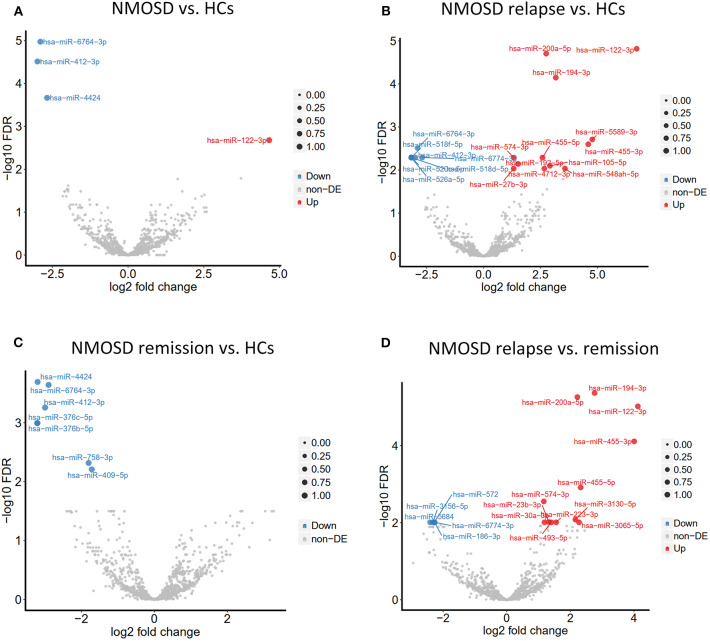
Volcano plots demonstrated different exosomal miRNAs profiles between NMOSD and HCs based on the NGS data. (A) The comparation of exosomal miRNAs profiles in NMOSD patients compared with HCs. (B,C) The comparations of exosomal miRNAs profiles between the subgroups of NMOSD and HCs. (D) The comparations of exosomal miRNAs profiles between relapsing NMOSD patients and remitting NMOSD patients. Non-DE, not differentially expressed.